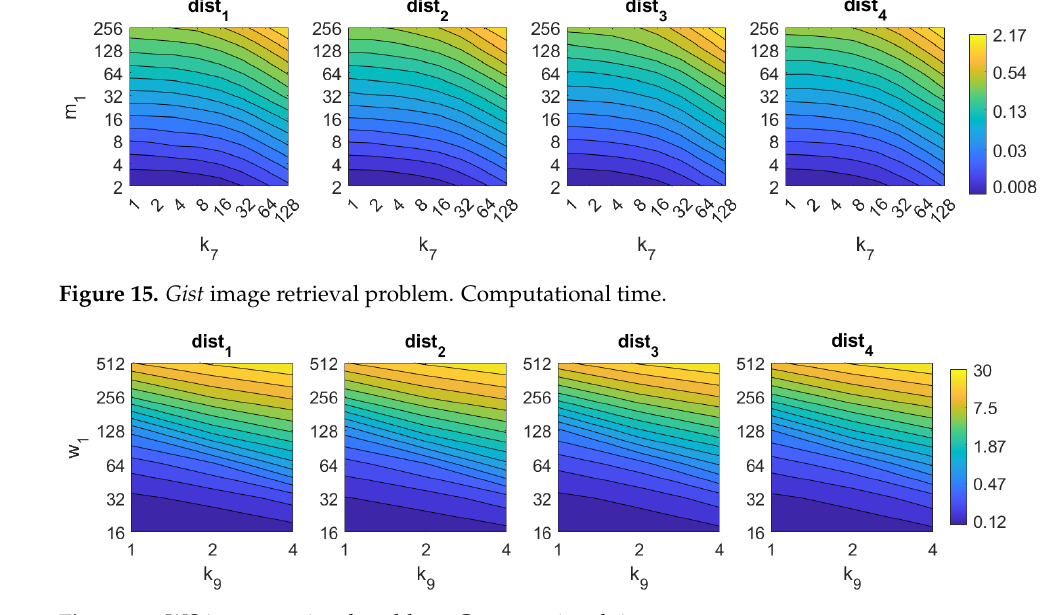
Figure 16. WS image retrieval problem. Computational